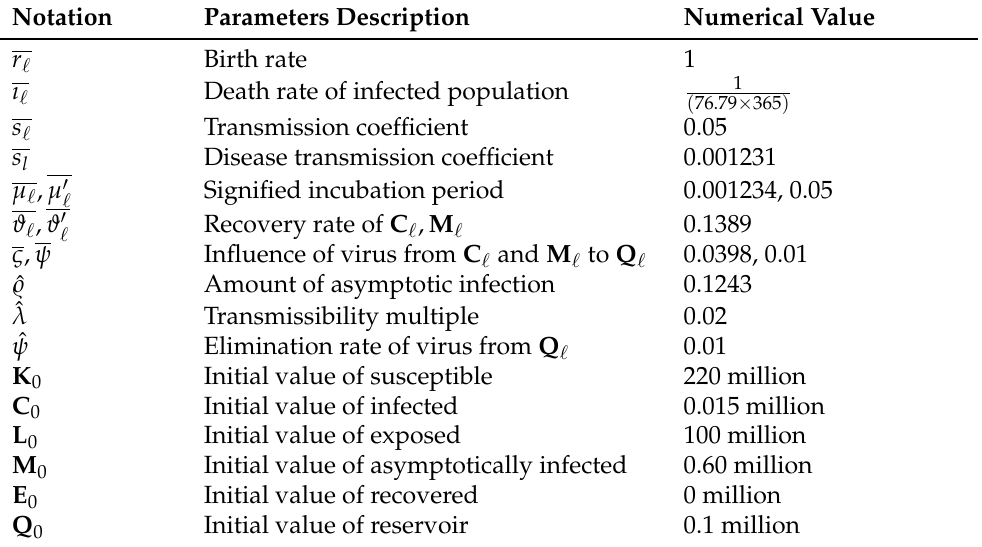
Table 1. Description of the model’s parameters